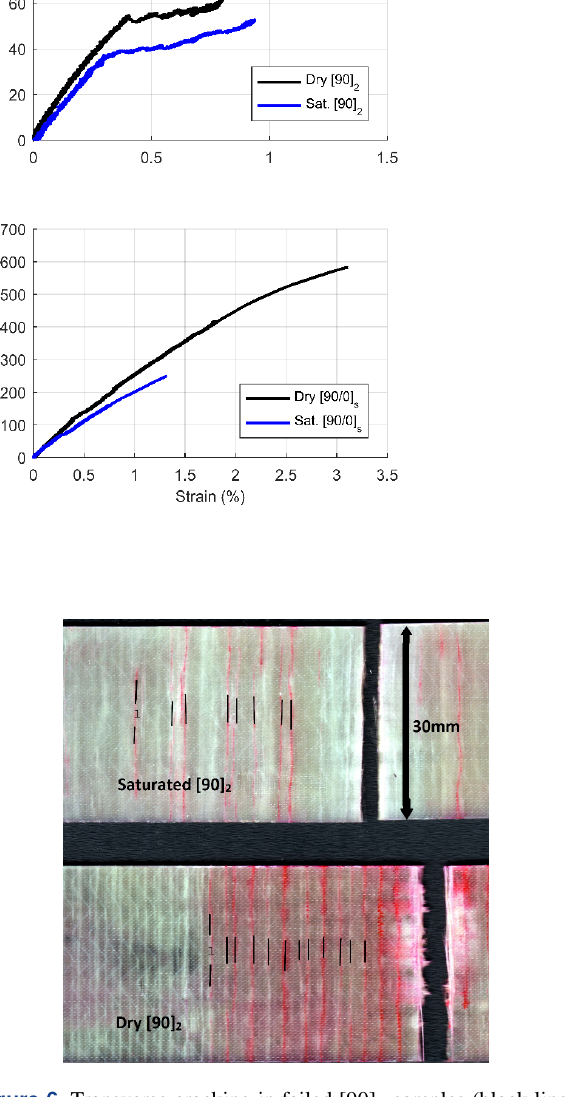
Figure 6. Transverse cracking in failed [90] 2 samples (black lines mark transverse